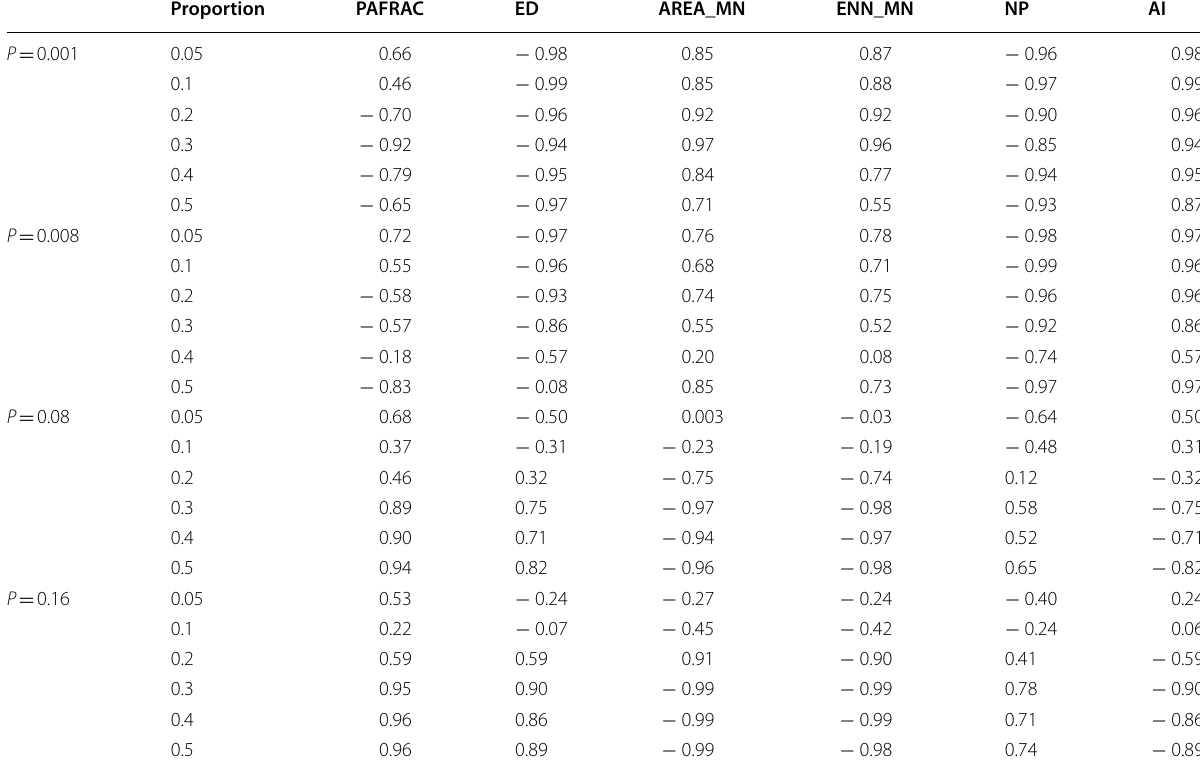
At p below 0.008, fragmented patterns of forest patches reduce pollination service, but at higher values of p , aggregated patterns increase